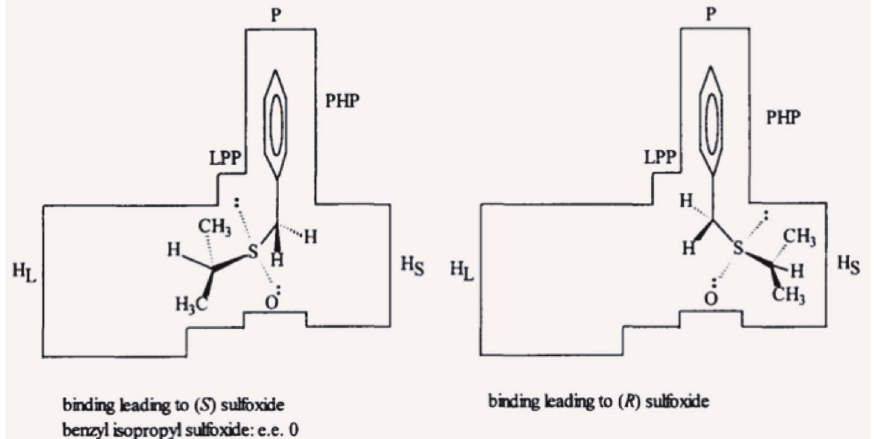
Figure 11 - Binding model for substrates bearing small alkyl groups (Holland et al. 1997b). Reprinted with permission from Elsevier (Holland et al. 1997b). Copyright 2015 Elsevier.